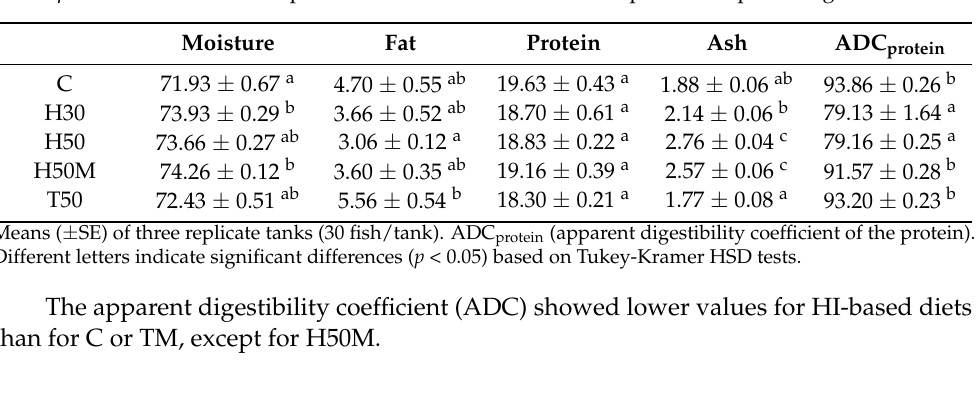
Table 5. Proximal composition of raw muscle and apparent digestibility coefficient of diet protein from Sparus aurata fed with experimental diets. All results are expressed as